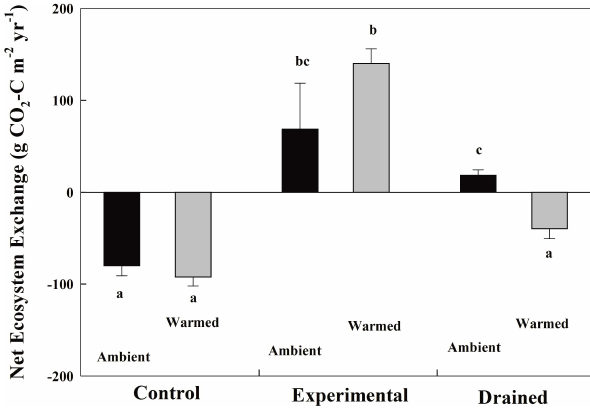
Figure 5. CO 2 –C balance averaged over study years (2011–2013). Error bars indicate ± standard deviation. Differences were evaluated between ambient and warmed sites (microforms) indicted by letters at each bar. Sites are significantly different at p <0.05 if they have no letters in